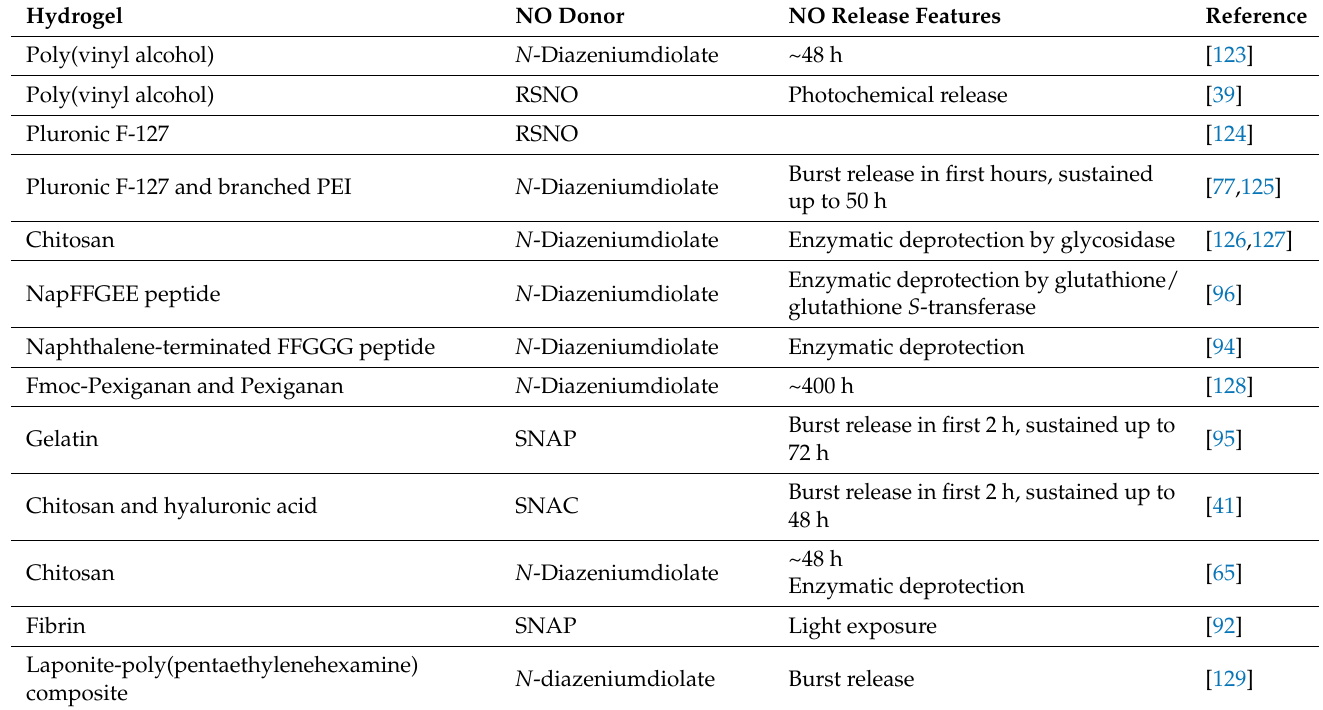
Figure 4. Nitric oxide capture ( A ) and release ( B ) by thiols (left) and amines (right) to originate S -nitrosothiols and N -diazeniumdiolates, respectively. Adapted from ref. [39]. Table 4. NO-releasing hydrogels based on covalently bound NO donors.